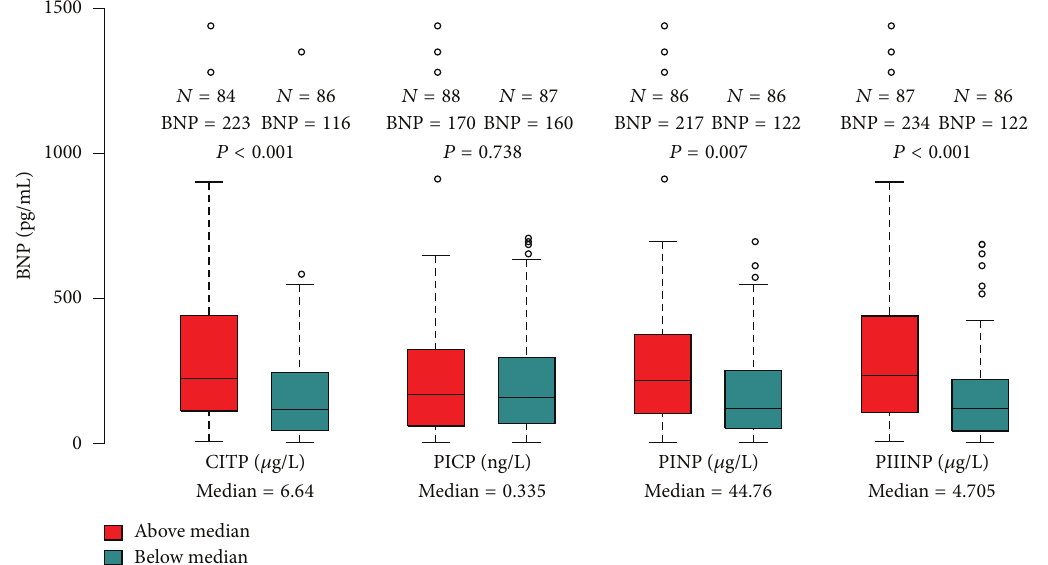
Figure 3: Boxplots of BNP (pg/mL) distribution when population is dichotomized by median values of collagen markers. Depicted labels indicate group size, median BNP, and Mann-Whitney 𝑈 test statistical